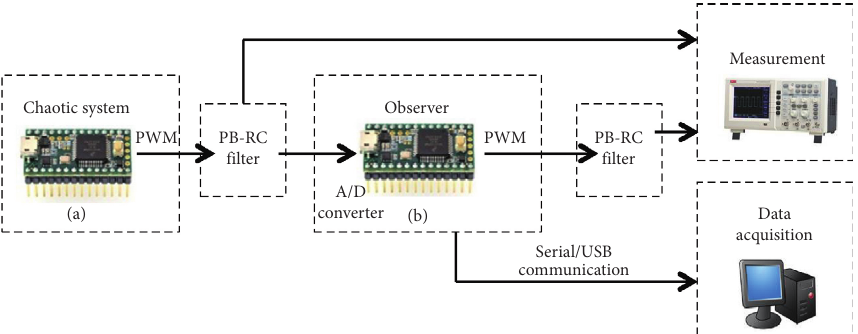
Figure 6: Block diagram of the